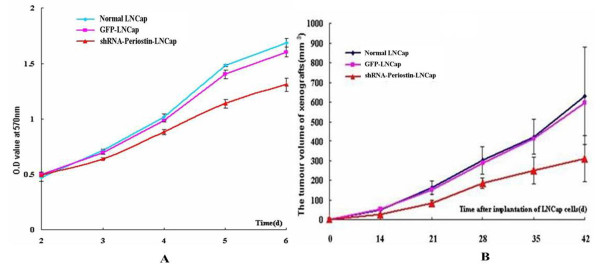
Sliencing Periostin inhibits the proliferations of LNCap cells in vitro and vivo. A: Growth curves of LNCap cells by MTT. Red represented LNCap cells transfected with shRNA-Periostin lentiviral particles. Green and pink represented normal LNCap cells and control GFP LNCap cells,respectively. From day 3, the stably expressing shRNA-Periostin LNCap cells started to grow slowly(P <0.05). B: The stably expressing shRNA-Periostin LNCap cells grew slowly in vivo. Red represented LNCap cells transfected with shRNA-Periostin lentiviral particles. Blue and pink represented normal LNCap cells and Control GFP LNCap cells, respectively.